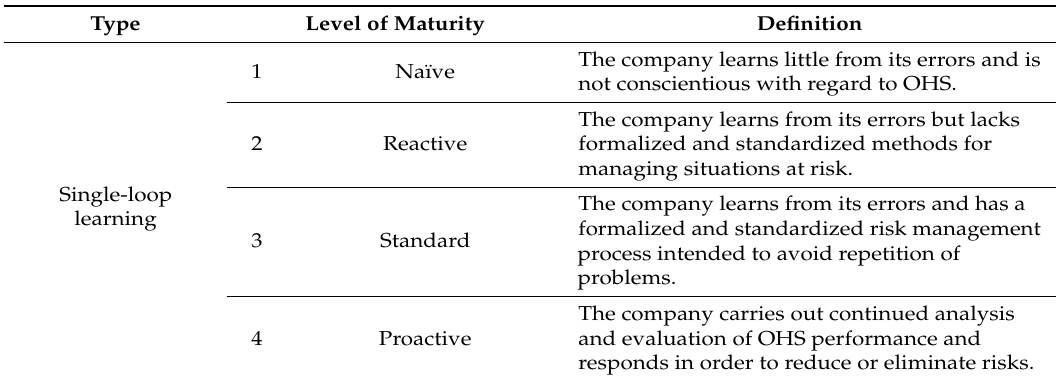
Table 6. Levels of OHS risk management maturity [32].